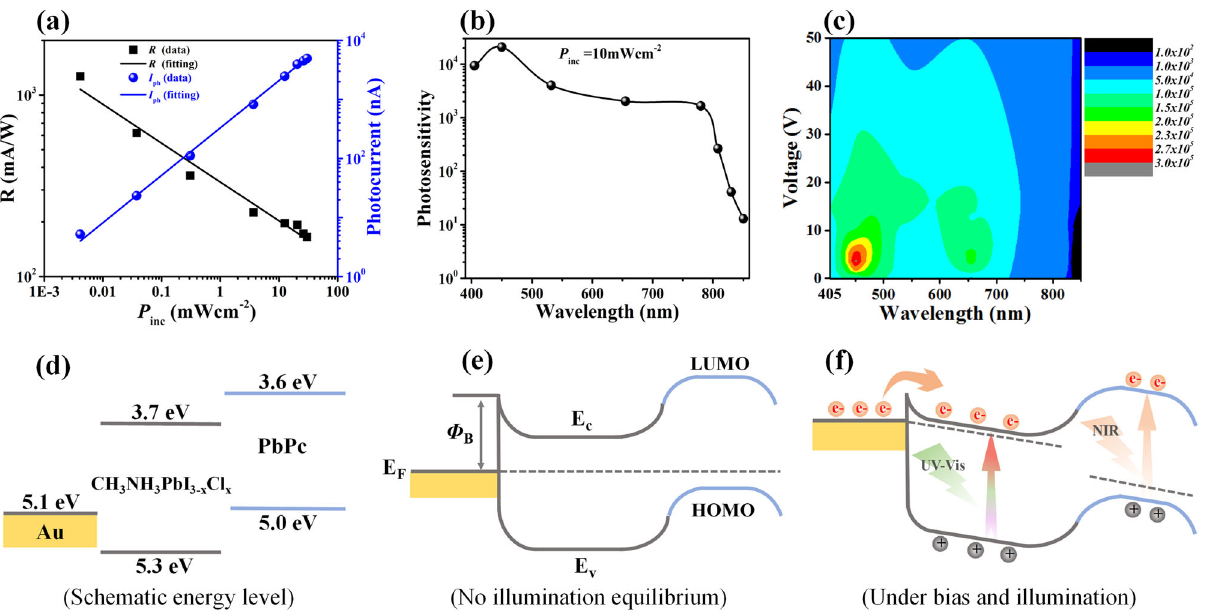
Fig. 6 Photosensitive properties and mechanisms of the perovskite-PbPc photodetectors. a Incident power dependence of photoresponsivity and photocurrent under 405nm illumination. b The dependence of photosensitivity on the incident wavelength. c Color plot of the maximum photosensitivity of as-prepared device as a function of wavelength and applied bias; the data is extracted from Fig. 3 and Supplementary Fig. S5. d Schematic energy level diagram of the adopted materials; these related values are based on refs. 16, 31. e Band diagram of the PbPc/MAPbI 3 − x Cl x photodetector in darkness. f Band diagram and charge transport of the PbPc/MAPbI 3 − x Cl x photodetector under bias and